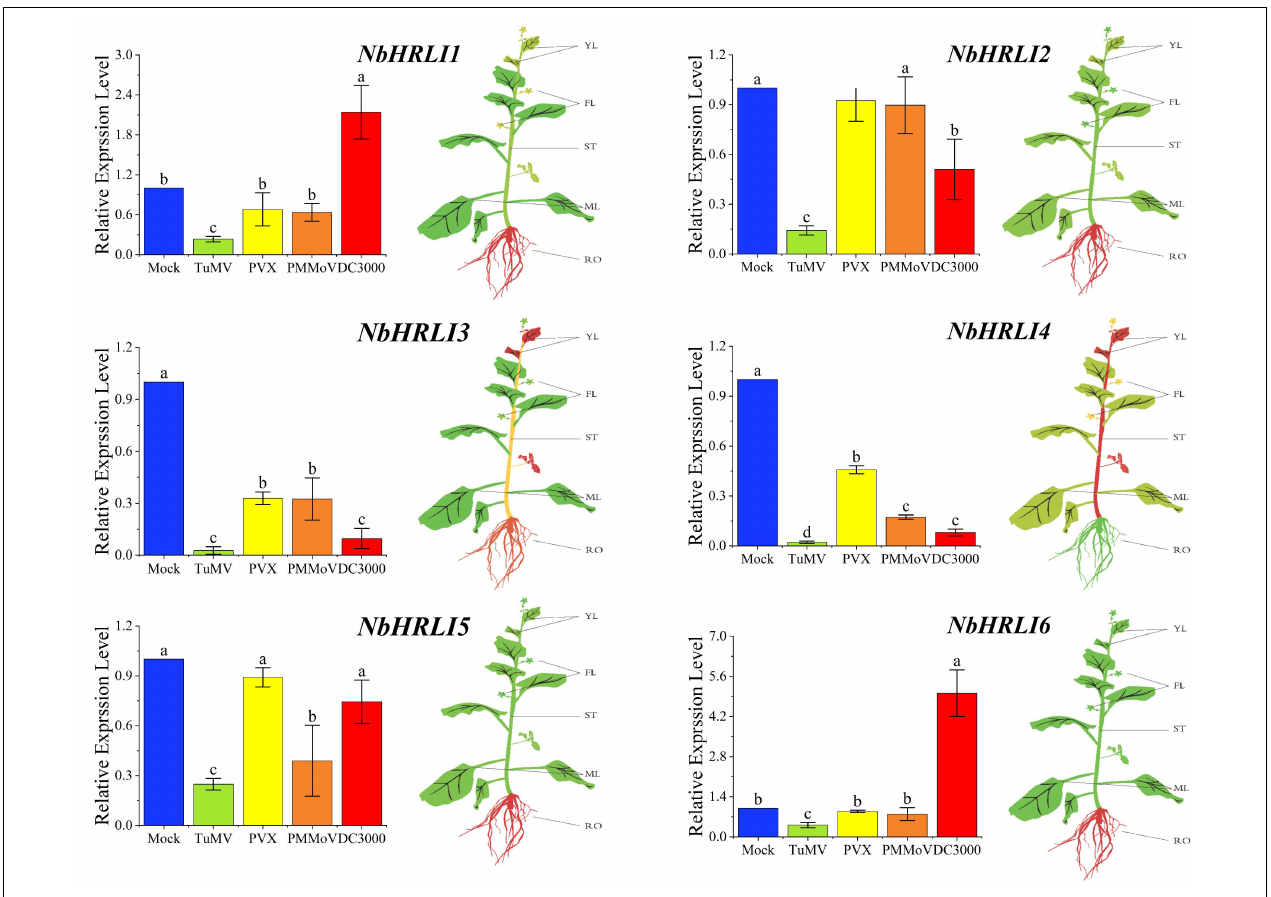
FIGURE 2 | The differential expression of NbHRLIs infected with different pathogens and in different tissues by RT-qPCR. YL, young leaf; MF, mature leaf; ST, stem; RO, root; FL, flower. The mean expression values were visualized by TBtools; red represents high expression level and green represents low expression level. N. benthamiana was mechanically inoculated with TuMV, PVX, and PMMoV and harvested at 5 dpi. N. benthamiana were infiltrated with a suspension of Pst DC3000 (OD 600 = 10 − 5 ) in 10 mM of MgCl 2 and harvested at 1.5 dpi. The mean expression values were analyzed using F -test. Different letters on histograms indicate significant differences ( P <